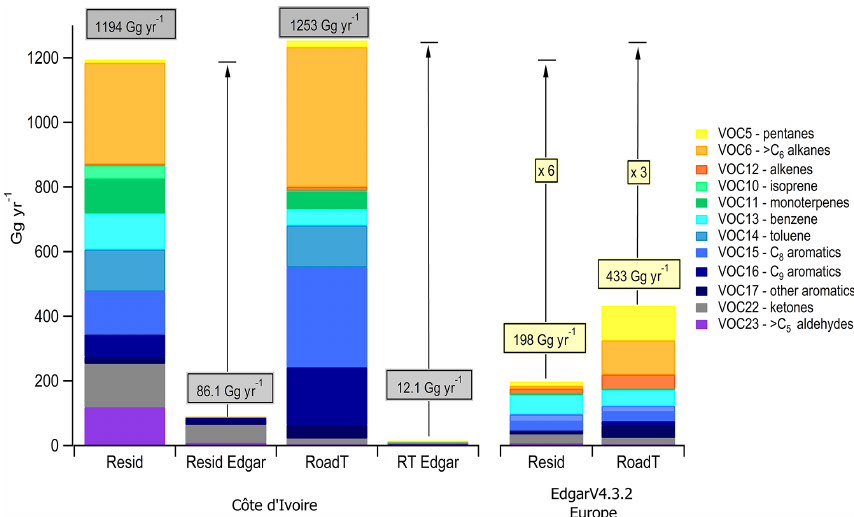
Figure 9. VOC emission profiles considering all the VOC families calculated from the measurements of our study and compared with the global EDGAR v4.3.2 inventory (Huang et al., 2017). The comparison integrates road transportation (RT) and residential (Resid) sectors in Côte d’Ivoire and Europe for the year 2012. Absolute emissions are expressed in Ggyr − 1 for each VOC group.